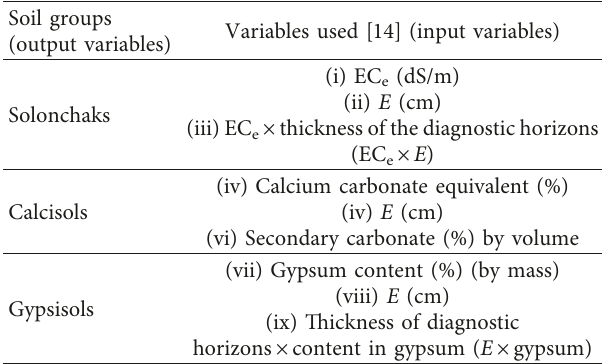
Table 2: Physical quantities of soil groups recommended by WRB